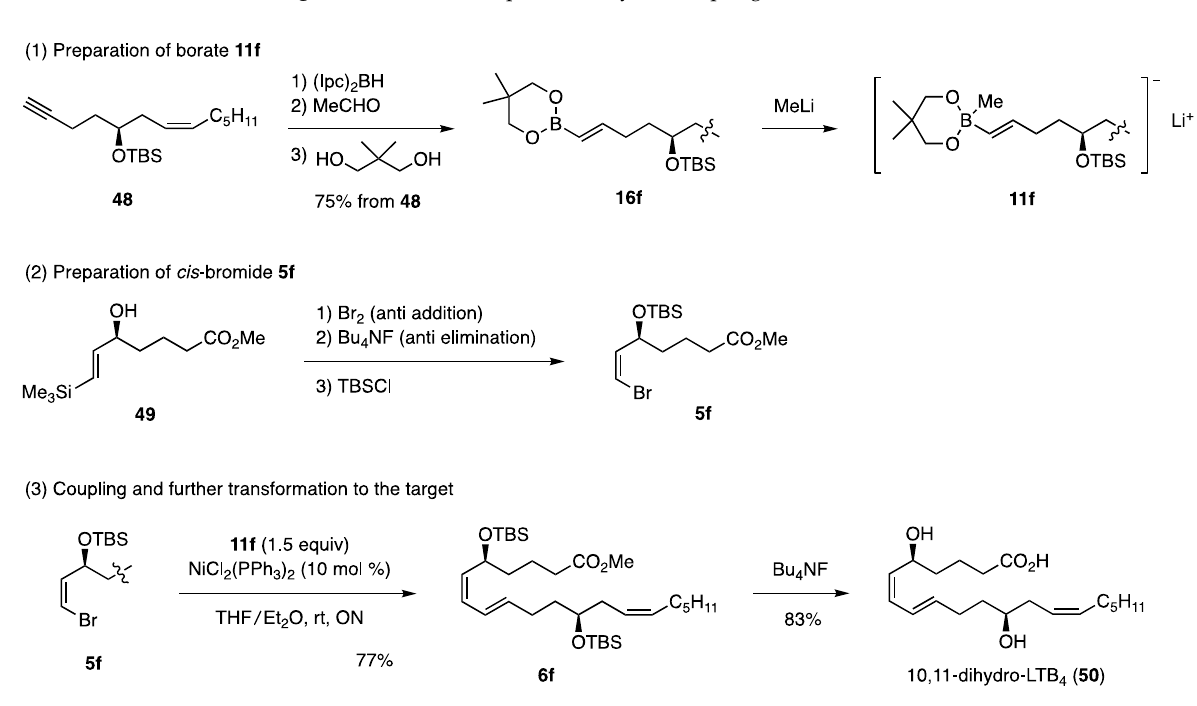
Figure 5. Other dienes produced by the coupling reaction.